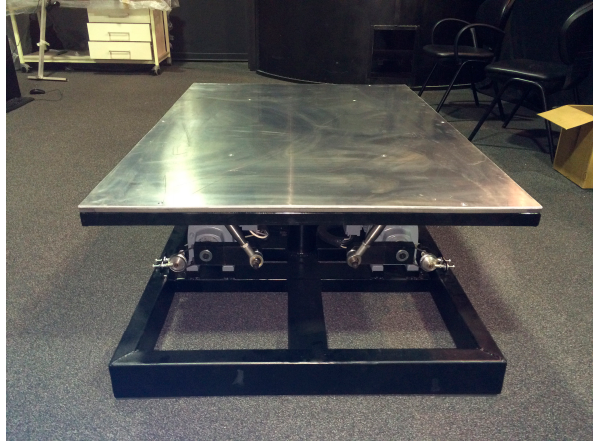
Figure 3. Example of a 2-DOF pitch-roll motion platform.